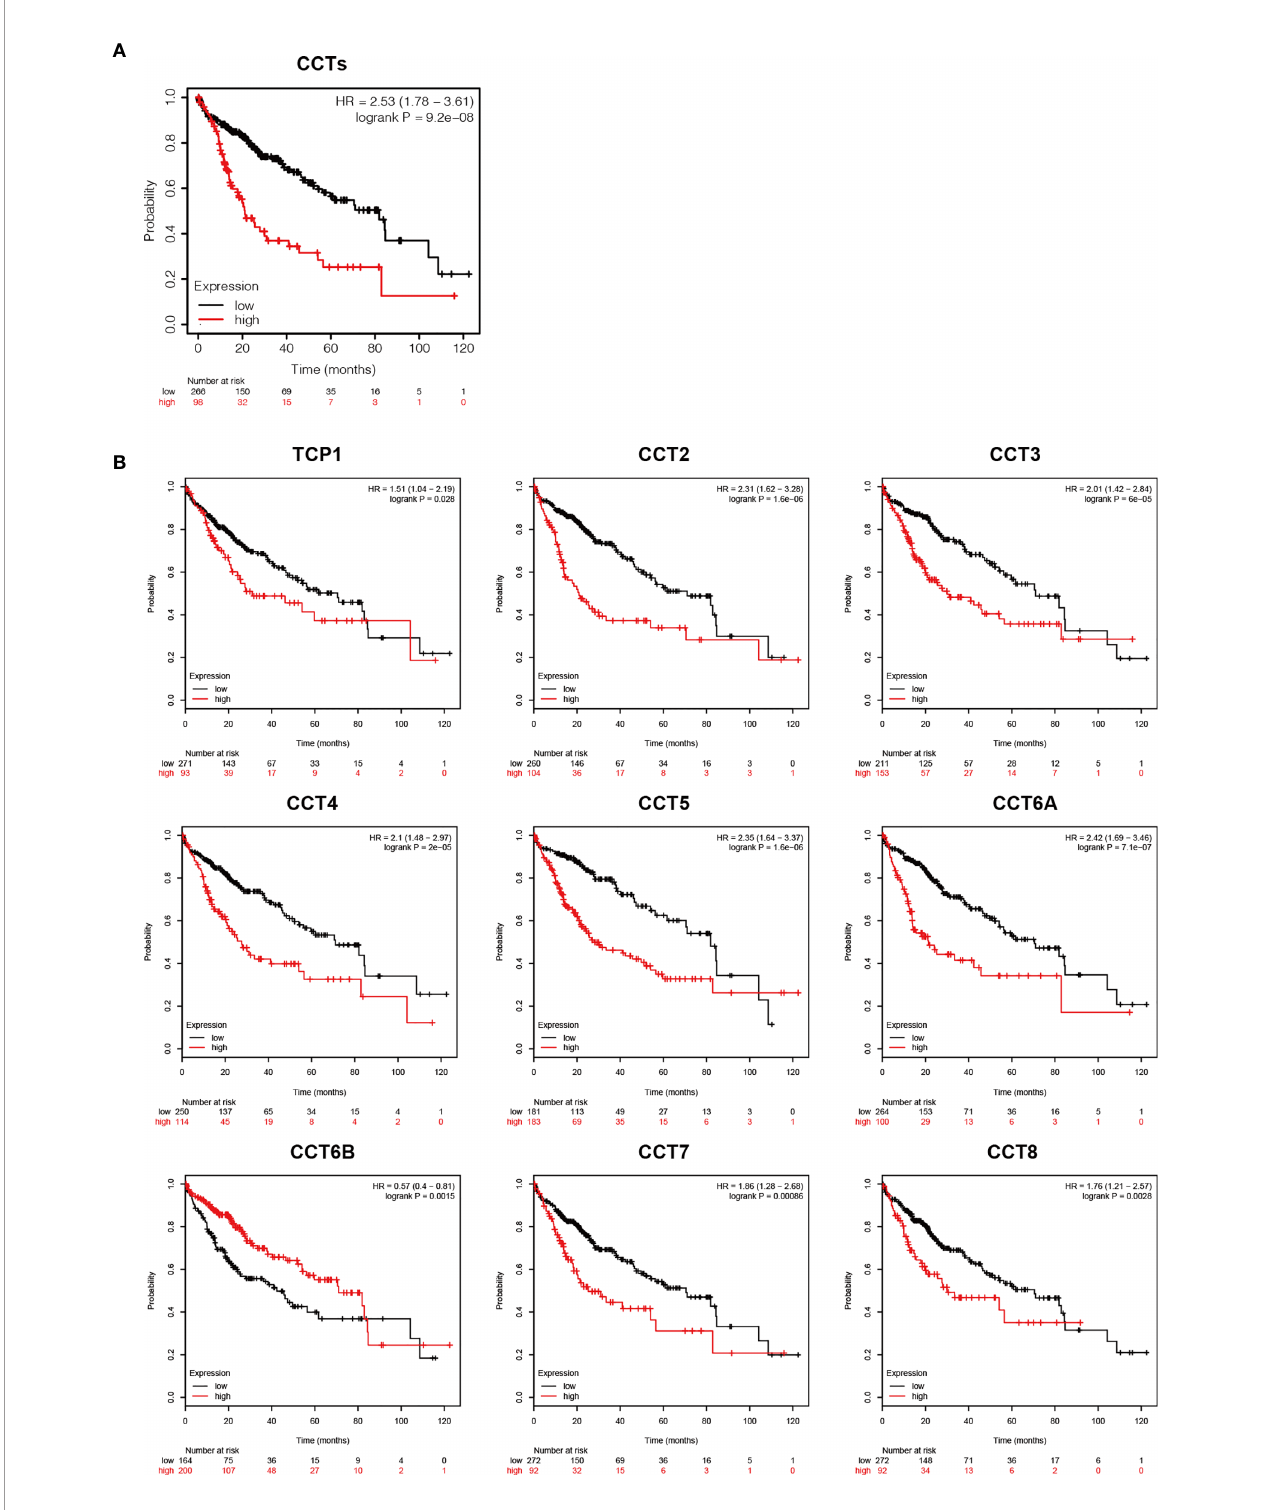
FIGURE 4 | Prognostic values of TRiC subunits for HCC (from UALCAN). (A) Survival analysis of the TRiC. (B) Survival analysis of individual TRiC